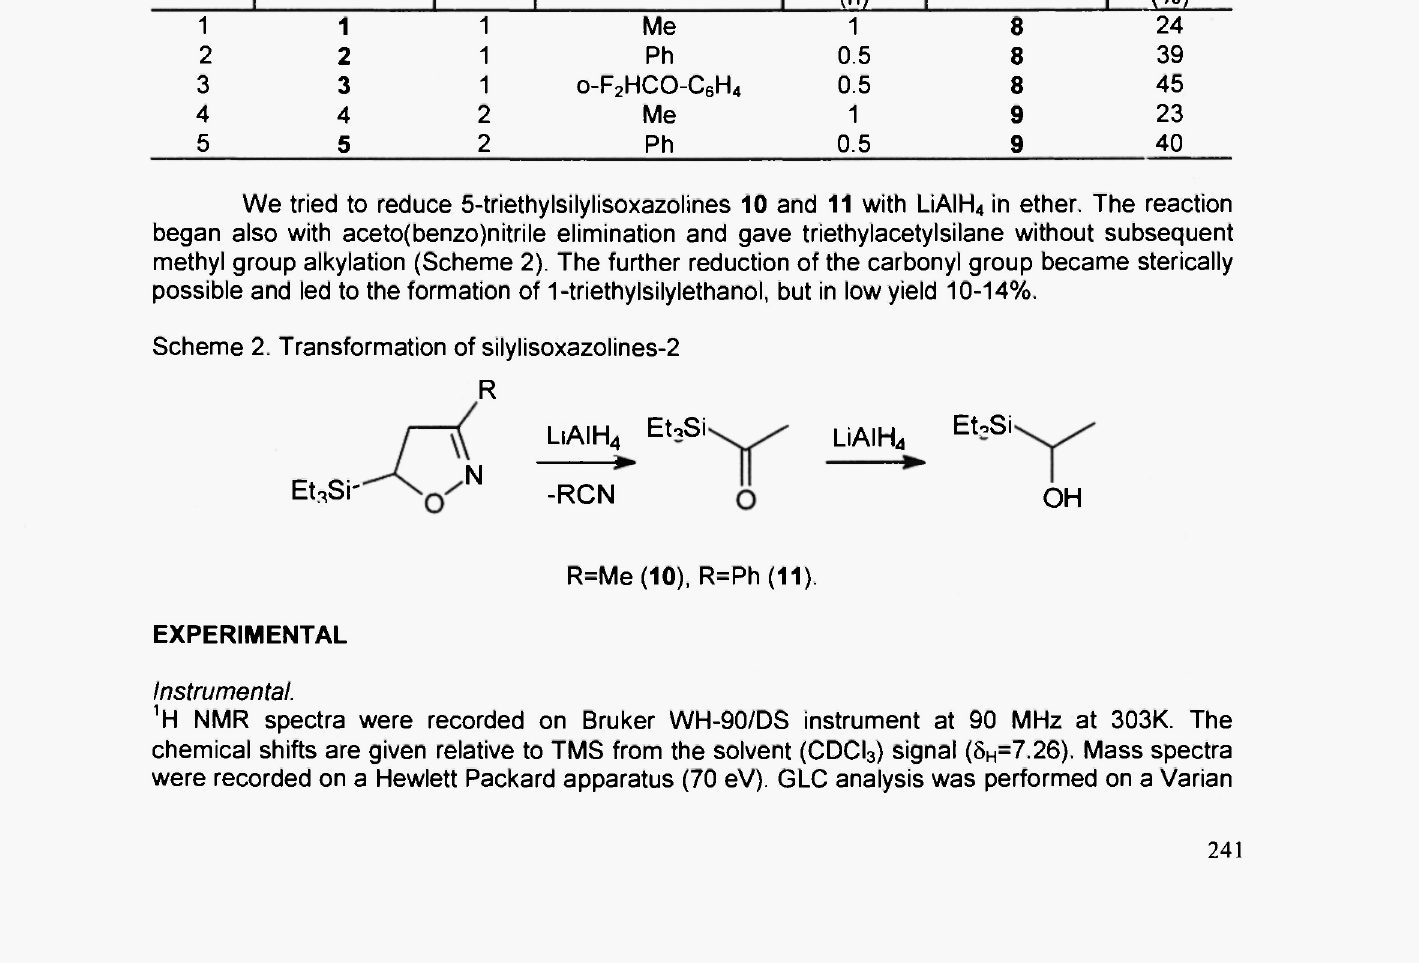
Et . Ge. CEt 4 n 3 Ο 8